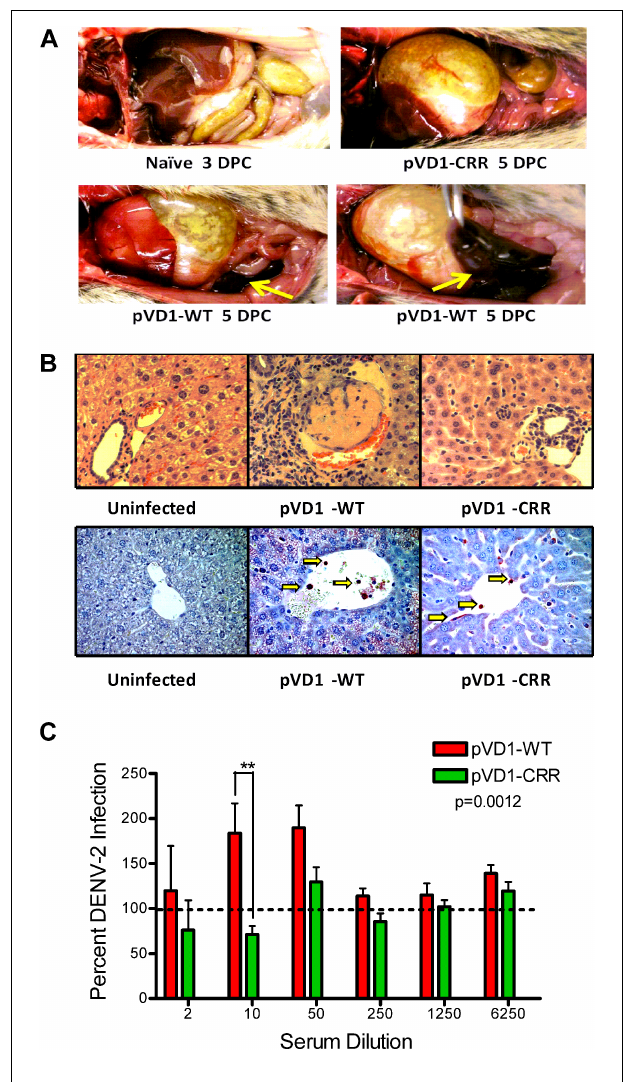
FIGURE 4 | Pathophysiology of enhanced DENV disease in vaccinated AG129 mice. (A) Enhanced DENV disease associated vascular leak pathology of pVD1-WT and -CRR vaccinated mice following sub-lethal heterologous DENV-2 infection. No pathology was visible in naïve or vaccinated mice 3 DPC, yet by 4 and 5 DPC mice succumbing to enhanced disease exhibited severe vascular leakage associated pathology.The same mouse is shown in the bottom two photos to highlight the severe intestinal hemorrhage observed in pVD1-WT but not in pVD1-CRR vaccinated mice (arrows). (B) Histology of uninfected, pVD1-WT, and pVD1-CRR vaccinated mouse livers 3 DPC.The top row is hematoxylin and eosin stained liver sections and the bottom row is immunohistochemistry for DENV-2 NS1 protein of the same individual animals. NS1 + mononuclear inflammatory cells and sinusoidal endothelial cells stain red in their cytoplasm and are visible (arrows) in liver tissue from vaccinated mice but not uninfected mice. Multiple sections from multiple animals were examined and single representatives are shown. All photos were taken at 400x magnification. (C) In vitro DENV-2 enhancement by pVD1-WT and pVD1-CRR vaccinated serum 12 weeks following vaccinations and one day prior to DENV-2 challenge. Consistent with the In vivo results, pVD1-WT vaccinated serum significantly enhanced DENV-2 infection whereas pVD1-CRR vaccinated serum did not ( p = 0.0012).The data are representative of two independent experiments of 4 pools of 6–7 individual serum specimens for each vaccine treatment and were analyzed with two-way ANOVA and Bonferroni post hoc test significance at individual dilutions is depicted with